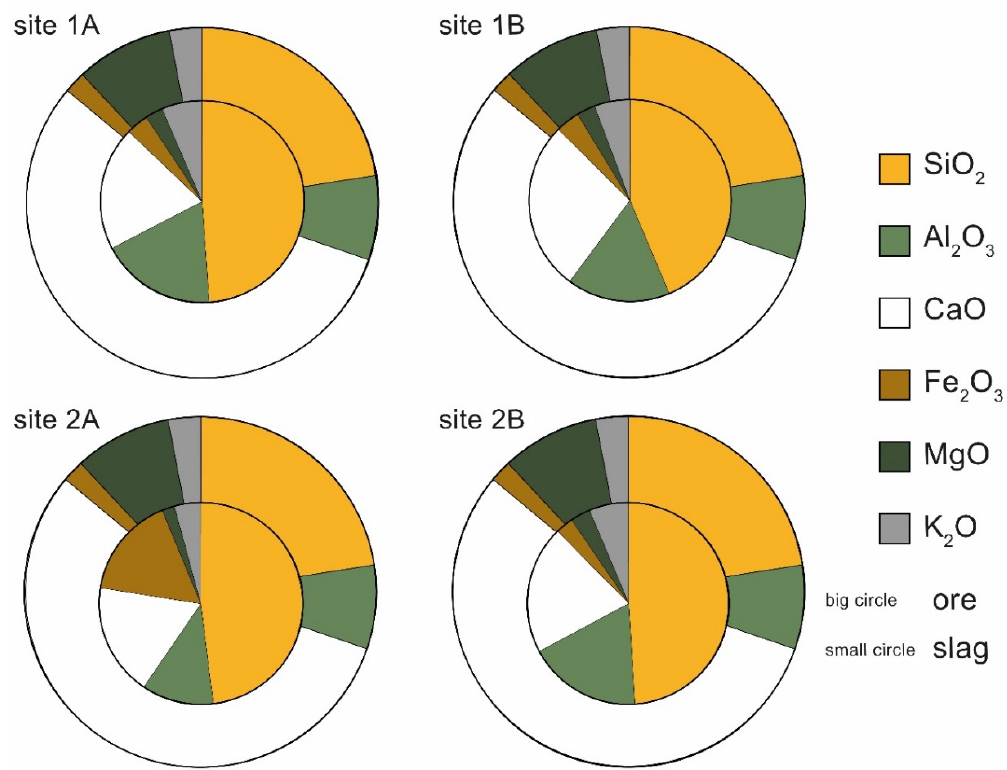
Figure 6. Comparison of ore (big circle in the background) and slag (small circle in the middle) percentage of major chemical components. Ore composition is calculated from all acquired rocks (as explained in the text), and slag composition is averaged for each site.